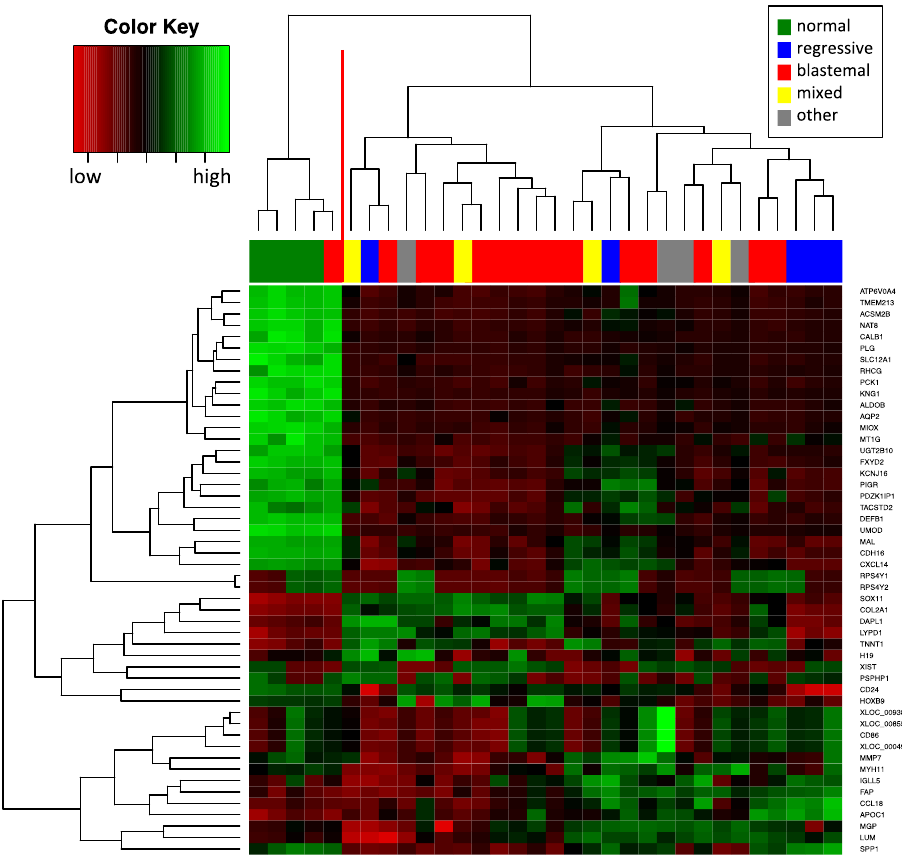
Figure 3. Unsupervised hierarchical clustering (Euclidian distance, complete linkage) of the 32 samples based on expression of the 50 mRNAs with highest variance. The heatmap shows mRNAs with high expression in red, mRNAs with low expression in green. The red line indicates two main clusters of samples.